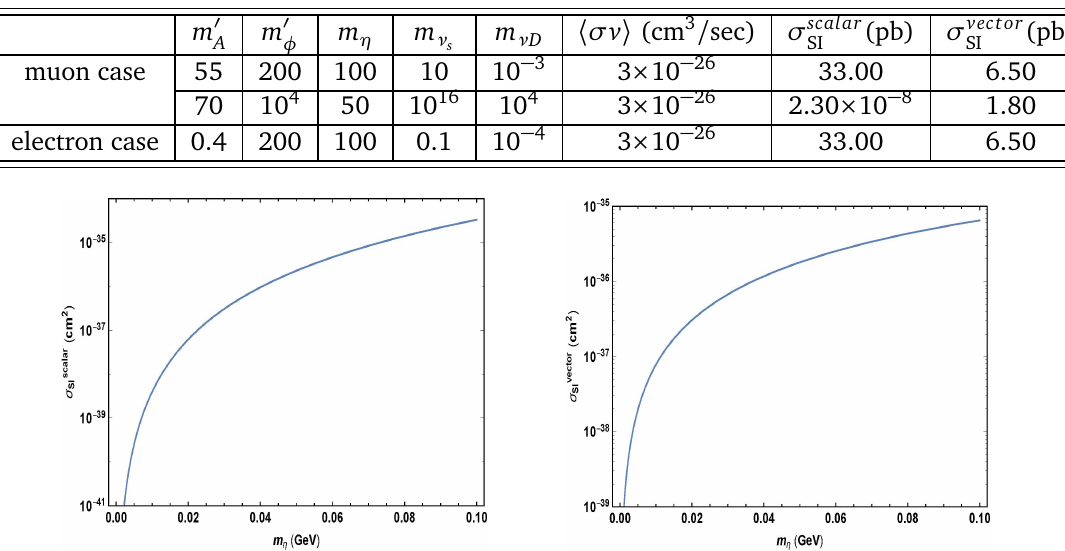
Table 13.2: Masses of A (cid:48) , φ (cid:48) and η (DM) in MeV and the corresponding thermal relic abundances are shown for two different model scenarios, i.e., muon and electron cases. The dark matter-nucleon scattering cross sections for each benchmark point are also shown. For the case of A (cid:48) -mediated inelastic scattering, δ is taken small.